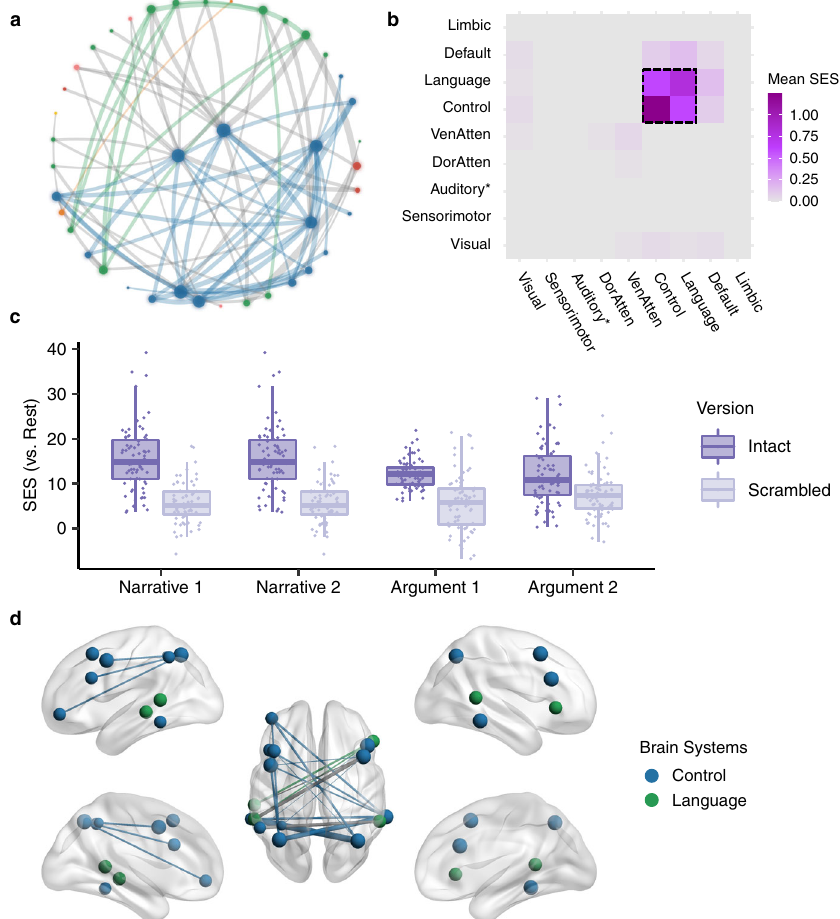
Fig. 7 The shared network for both narrative and argumentative thought. a The network layout of the shared brain network for narrative and argumentative thought using the force-directed graph drawing algorithm. It consisted of 88 edges. The color legend is the same as the one in Figs. 4, 5. b The distribution of 88 edges within and between brain systems, where each cell indicates the mean standardized effect size (SES) in the contrast between the intact and the scrambled conditions, i.e., the ratio of the sum of the SES to the number of the edges in the fully connected situation. As highlighted in the dotted box, most of the signi fi cant edges were within the control and the language systems. c The SES of the edges of all the conditions in contrast to the resting state within the control and the language systems. d The top 20 edges with the largest SES in the contrast between the intact and the scrambled conditions within the language and the control systems. In a , d the size of the nodes denotes the node degree of each brain area in the whole graph comprising 88 edges. The color of the nodes denotes to which brain system they belong. The width of the edges denotes the SES. Intra-system edges are in the color of that network; inter-system edges are in